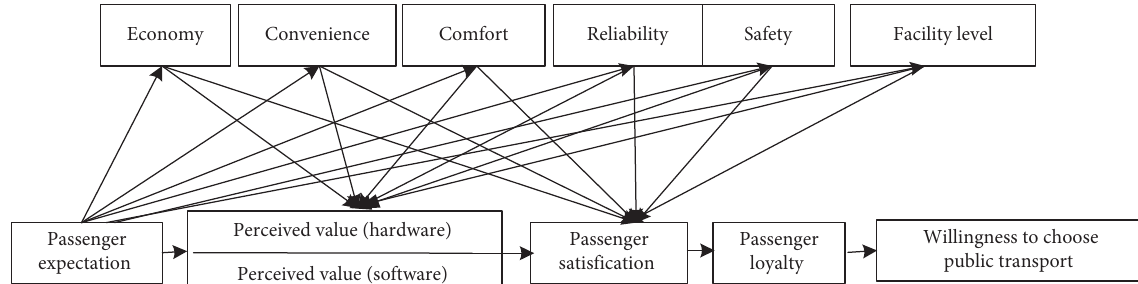
Figure 5: Influence mechanism of service level of public transport.